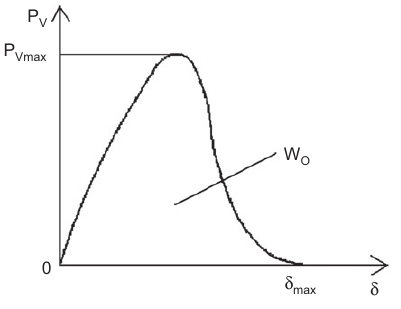
Figure 2 Full curve of P - δ . Figure 4 Effect of the polypropylene fiber on the slump flow. V